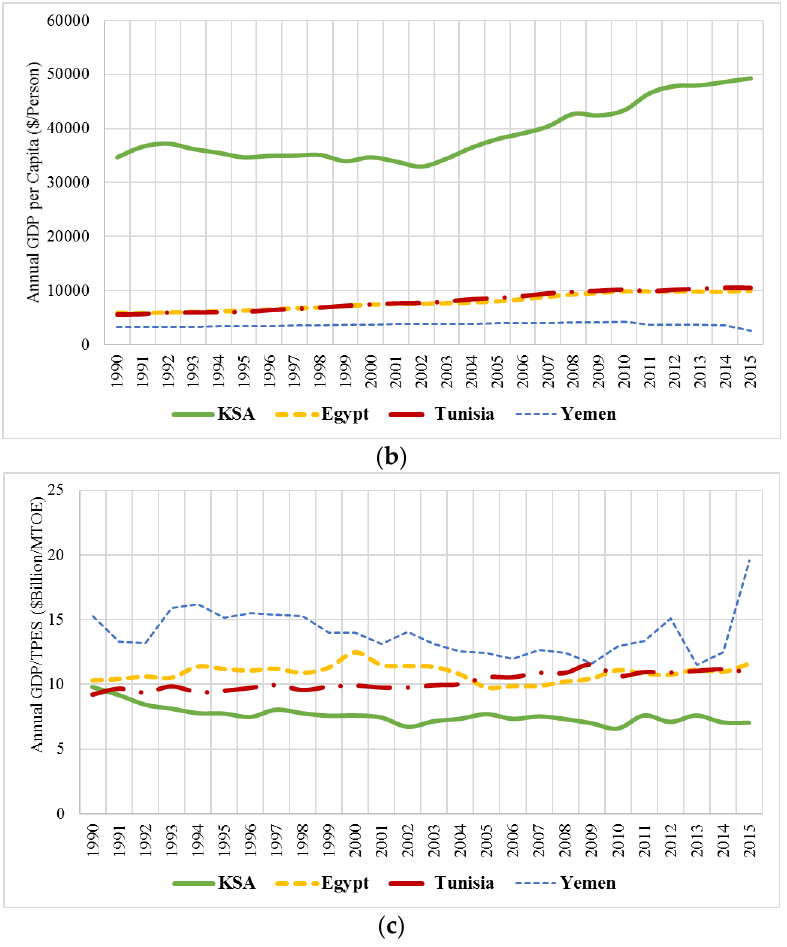
Figure 6. Annual variation of ( a ) per capita GDP, ( b ) per capita TPES, and ( c ) energy productivity for Saudi Arabia (KSA), Egypt, Tunisia, and Yemen.